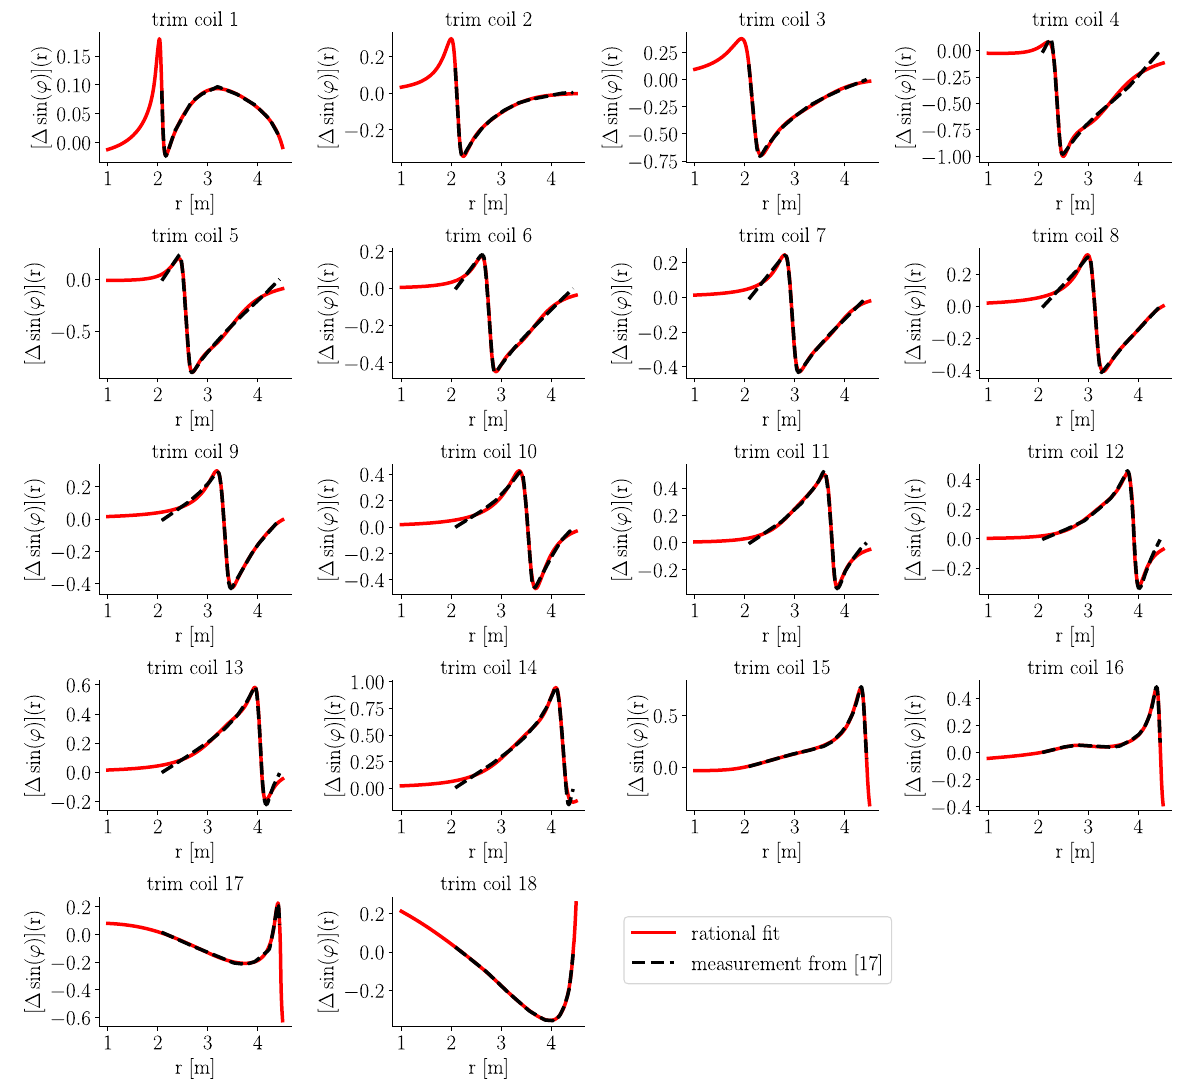
FIG. 9. Fits of the Δ sin ð φ Þ measurements using rational functions. The change of the beam phase φ is induced by the trim coil